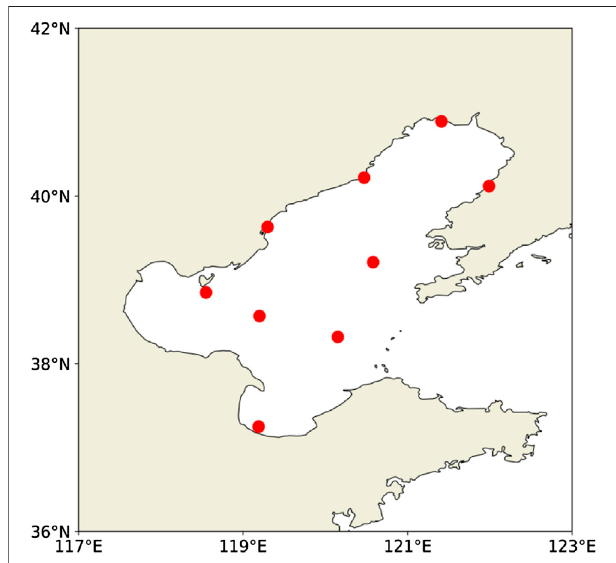
FIGURE 1 | The distribution of representative stations in coastal and offshore